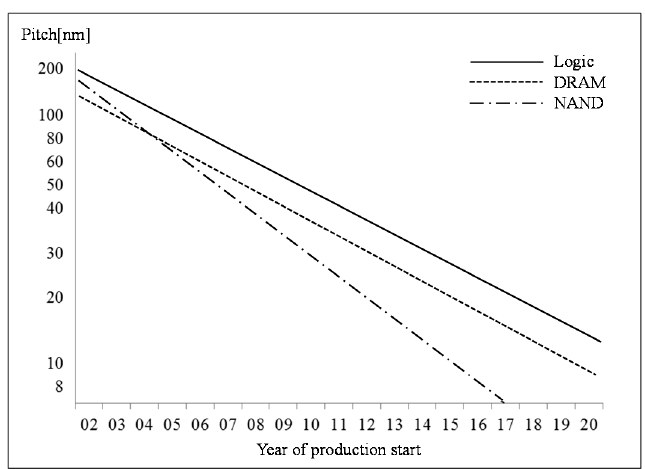
Figure 2. Pitch change in the lithography process (2002–2020). DRAM, Dynamic Random-Access Memory; NAND, Negative-AND gate flash memory.